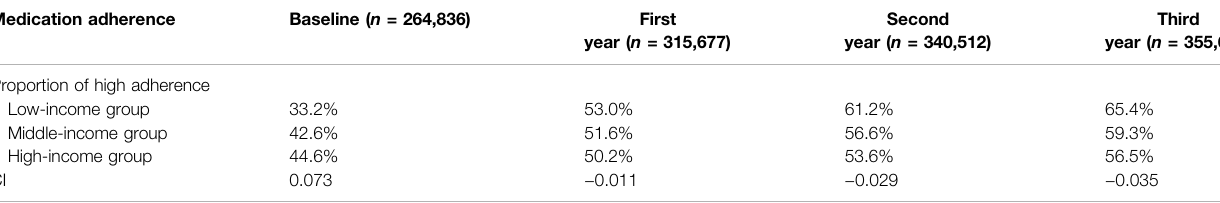
TABLE 2 | Medication adherence and CI of the 4